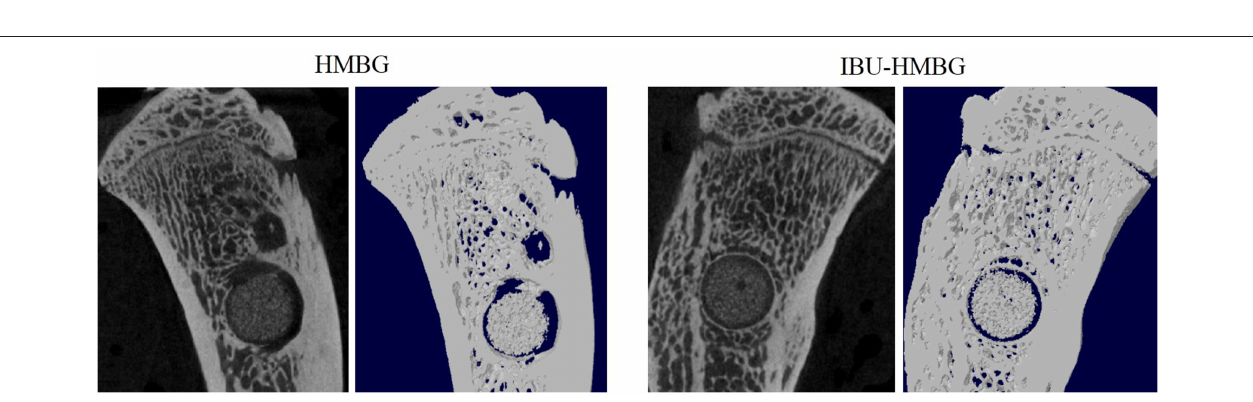
FIGURE 10 | Micro-CT evaluation of bone regeneration in the rat tibia defects with implantation of HMBG and IBU-HMBG samples after 4